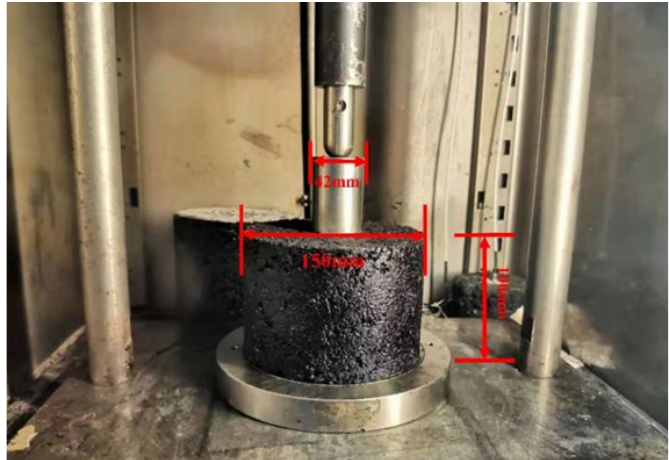
Figure 5. Loading device for uniaxial penetration creep test.